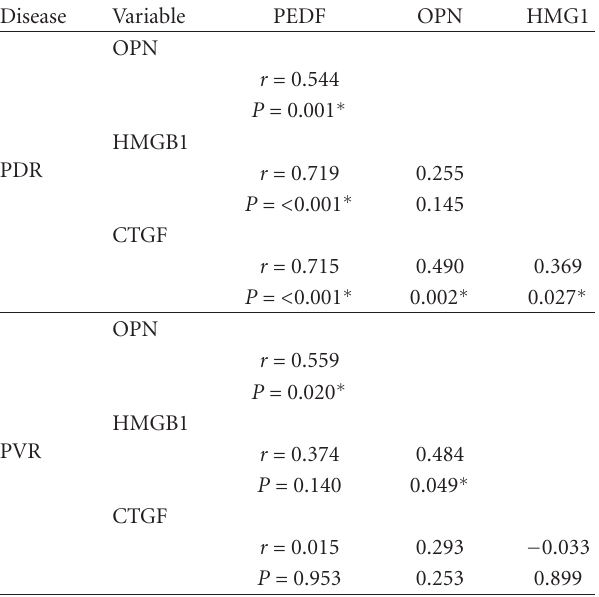
Table 4: Pearson correlation coe ffi cients between variables in proliferative diabetic retinopathy (PDR) and proliferative vitreo- retinopathy (PVR)